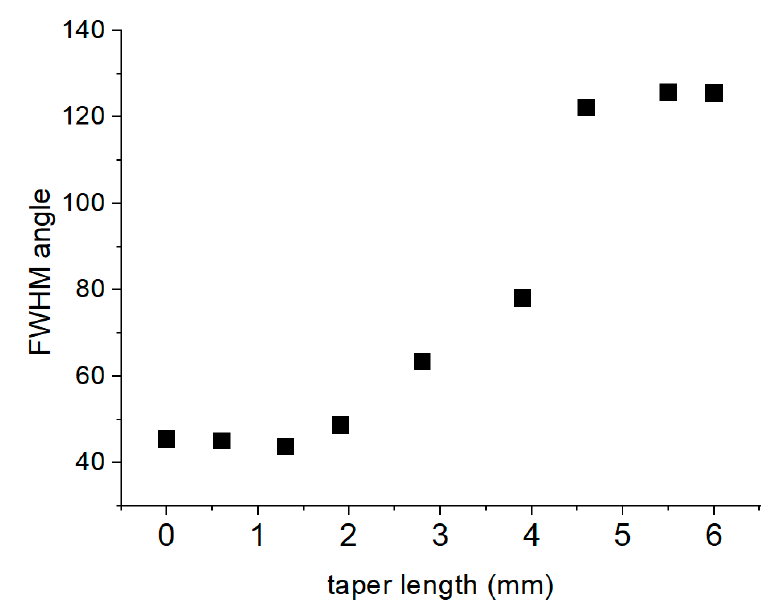
Figure 14. FWHM as a function of taper length with cutback technique. Points represent average